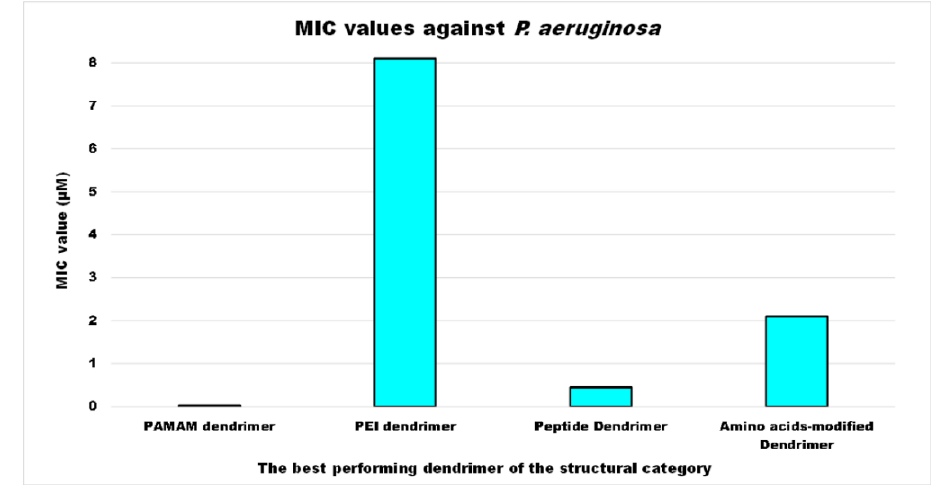
Figure 5. Antibacterial activity of the best performing compounds for one structural category of CADs against P. areruginosa .